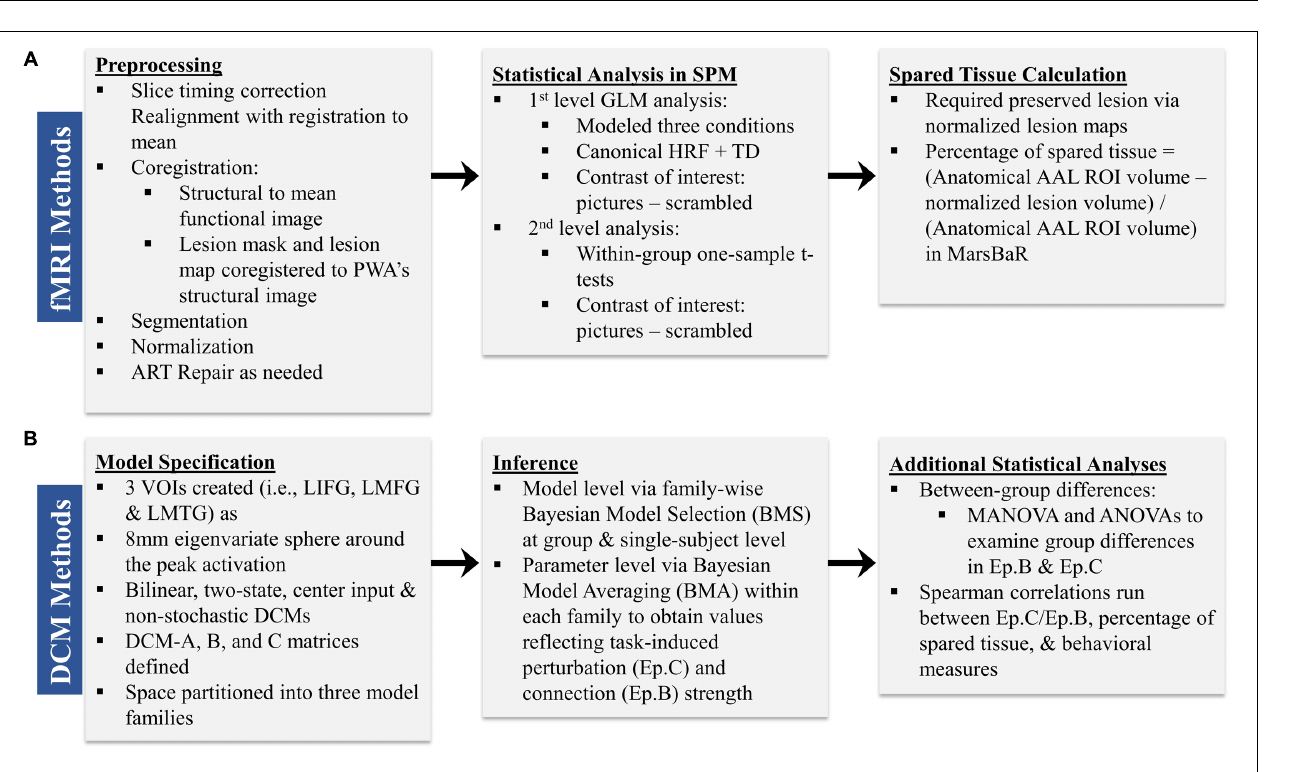
FIGURE 2 | Lesion overlap of all thirteen PWA included in the DCM analysis.